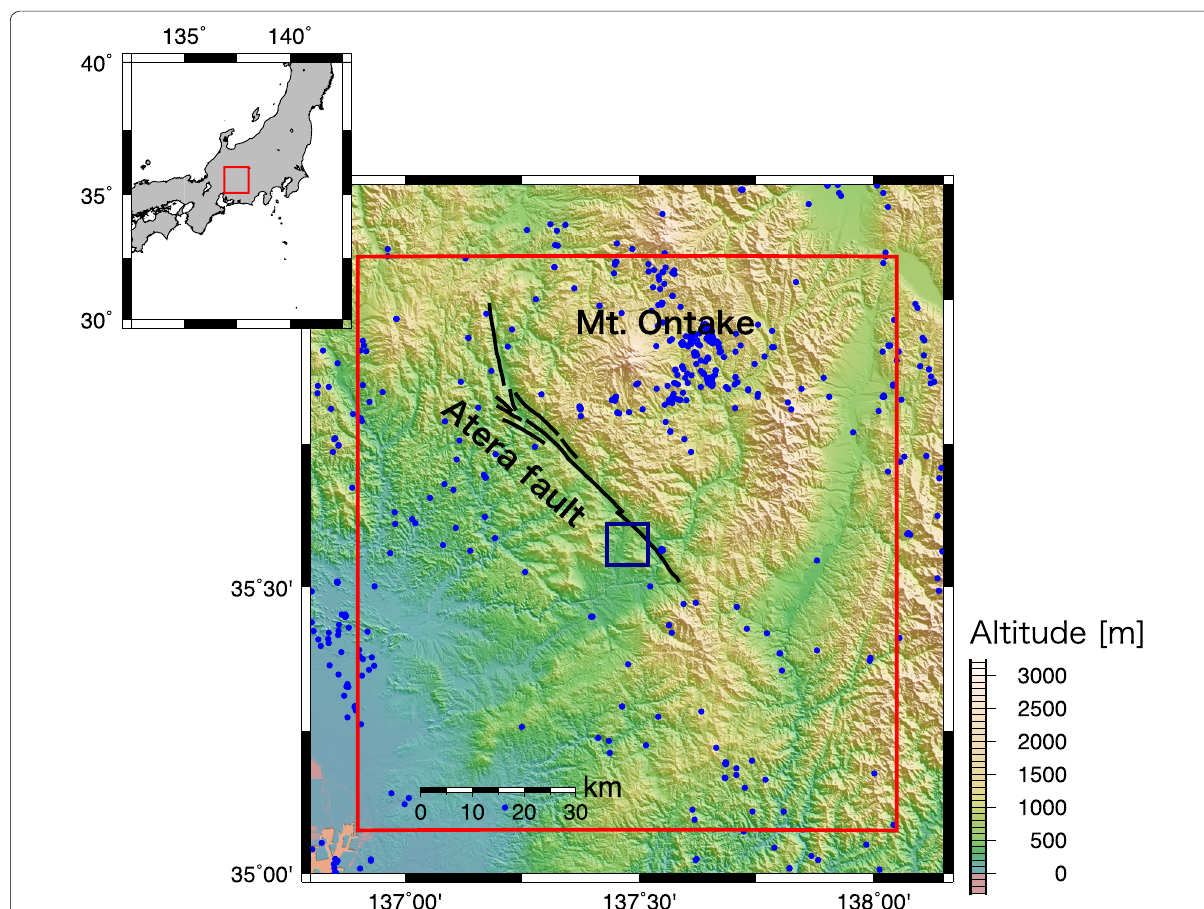
Fig. 1 The area of this study. Topography within the red square is taken into account for stress calculation. The small blue square is the area shown Fig. 2. The blue small circles denote shallow seismicity (2001–2010) with magnitude of > 1 and a depth of < 20 km around the Atera Fault determined by Japan Meteorological Agency. The black lines denote the Atera